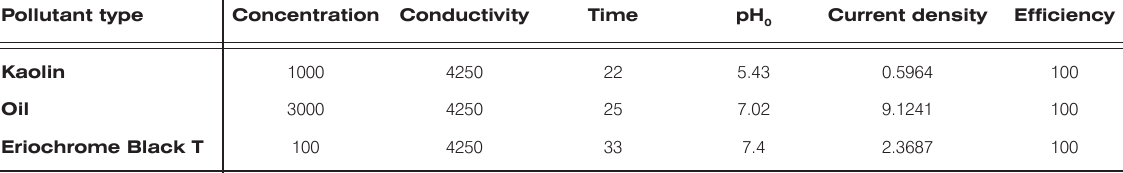
Table 3. Experimental and simulation results obtained through ANN-GA optimization method.